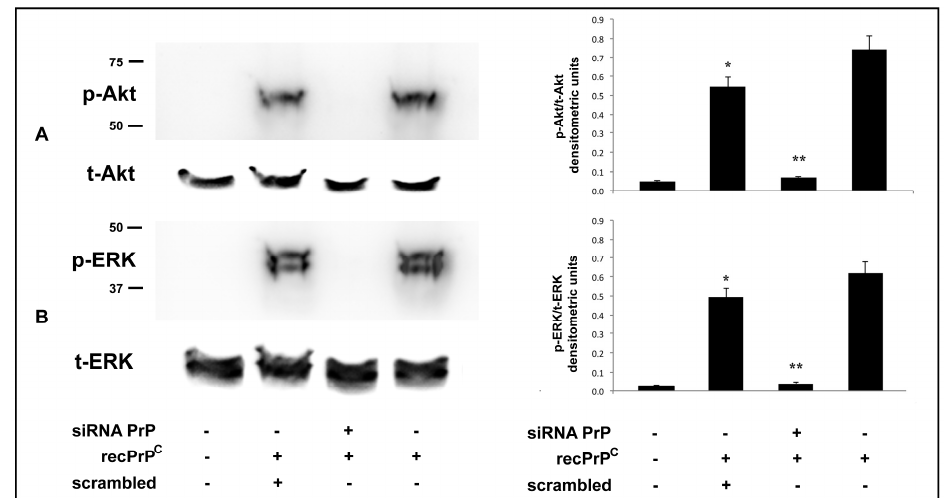
Figure 2. Effect of PrP C silencing on Akt and ERK phosphorylation induced by recPrP C . hDPSCs, untreated or treated with 0.5 µg/mL of recPrP C for 10 min in presence or in absence of pre-treatment with siRNA PrP or scrambled siRNA for 72 h, were analyzed by Western blot using anti-pAkt, anti-total Akt ( A ), anti-pERK1/2 and anti-total ERK1/2 ( B ). Densitometric analysis is shown in the right panel. Results represent the mean ± SD from 3 independent experiments, * p recPrP C treated cells <0.01 vs. untreated cells, ** p siRNA PrP + recPrP C treated cells vs. scrambled + recPrP C treated cells. As control, scrambled siRNA was employed in each experiment.